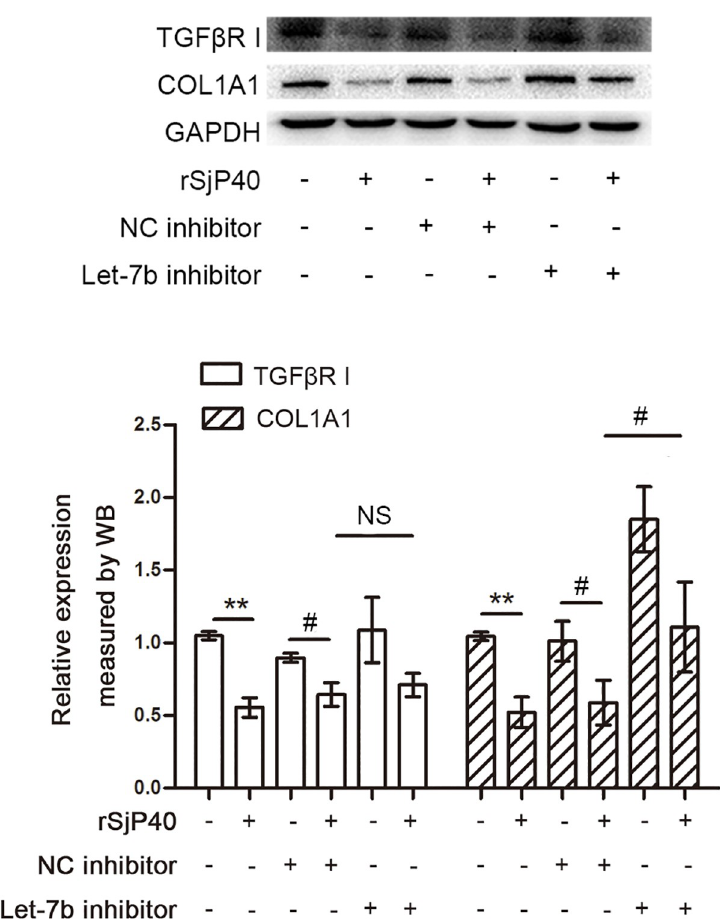
Fig 3. Let-7b participates in rSjP40-induced inhibition of LX-2 cell activation by targeting collagen I. rSjP40 suppresses levels of collagen I and TGF β I, but only expression of collagen I could be restored by the let-7b inhibitor. �� p < 0.01, compared with control group. # p < 0.05, compared with group transfected with NC inhibitor and treated with rSjP40. NS p > 0.05, compared with group transfected with NC inhibitor and treated with